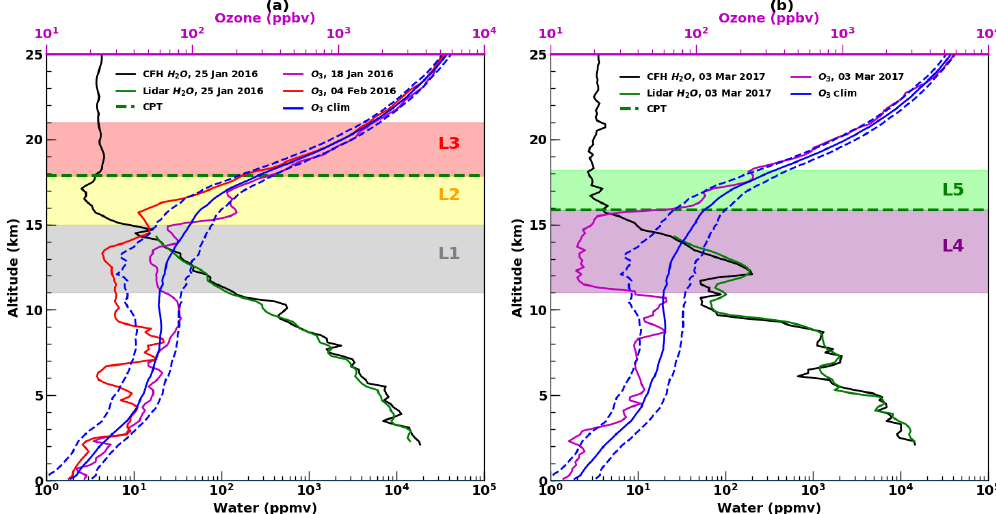
Figure 4. Vertical profiles of (a) CFH and lidar water vapor profiles (ppmv) on 25 January 2016 (black and green line, respectively) and NDACC/SHADOZ ozone profiles on 18 January 2016 (purple line) and 4 February 2016 (red line); (b) CFH and lidar water vapor profiles (black and green line respectively) and NDACC/SHADOZ ozone profile (purple line) on 3 March 2017. The location of the cold point tropopause is indicated by the dashed green line. Also shown in each plot is the 1998–2017 climatological mean ozone profile (blue line) for DJFM and the ± 1 standard deviation of the climatology corresponds to the dashed blue line The most important layers in the water vapor/ozone profiles are shaded and